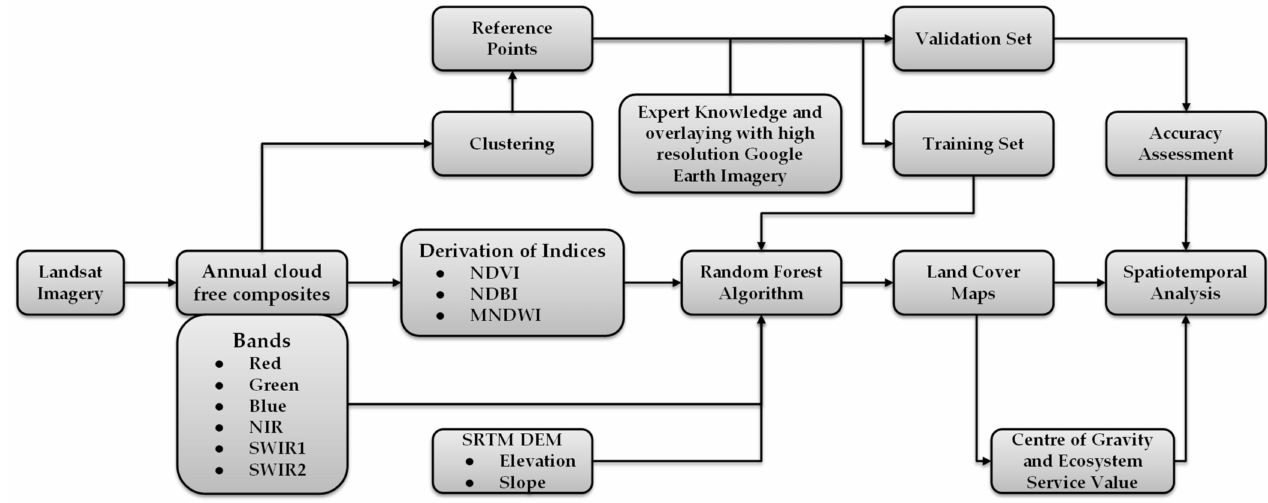
Figure 3. Workflow adopted in this